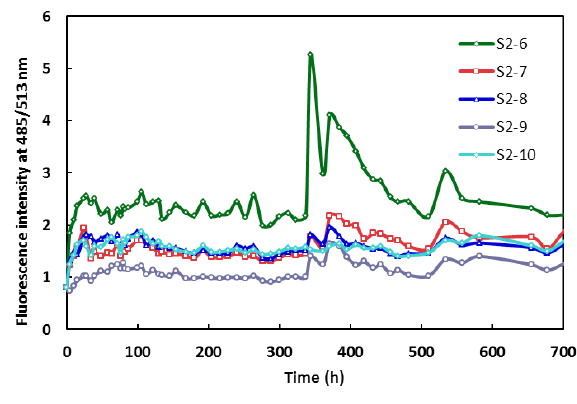
Figure 8 : Fluorescence in wells S2-6 and